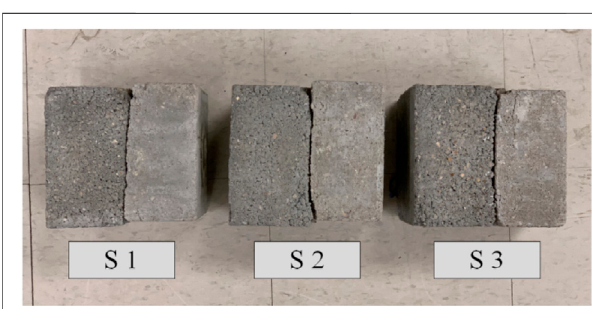
Figure 5 . It is noted that the position of wood blocks and steel